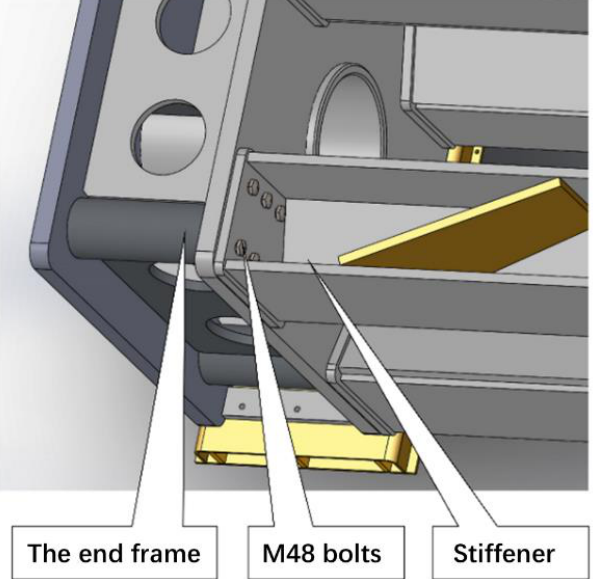
Figure 3. Connection form of the end frame and the middle frame. The middle frame coupling was welded together from two moment loading counter- force frames and stiffener couplings. The moment cylinder mounting plate was installed on the upper part of the moment loading counterforce frame. The moment cylinder mounting plate could be rotated 90 degrees along the horizontal direction. The upper part of the moment loading reaction frame was slotted, and the U-shaped structure was convenient for lifting the riser specimen up and down. The connection form of the frame coupling is shown in Figure 4.